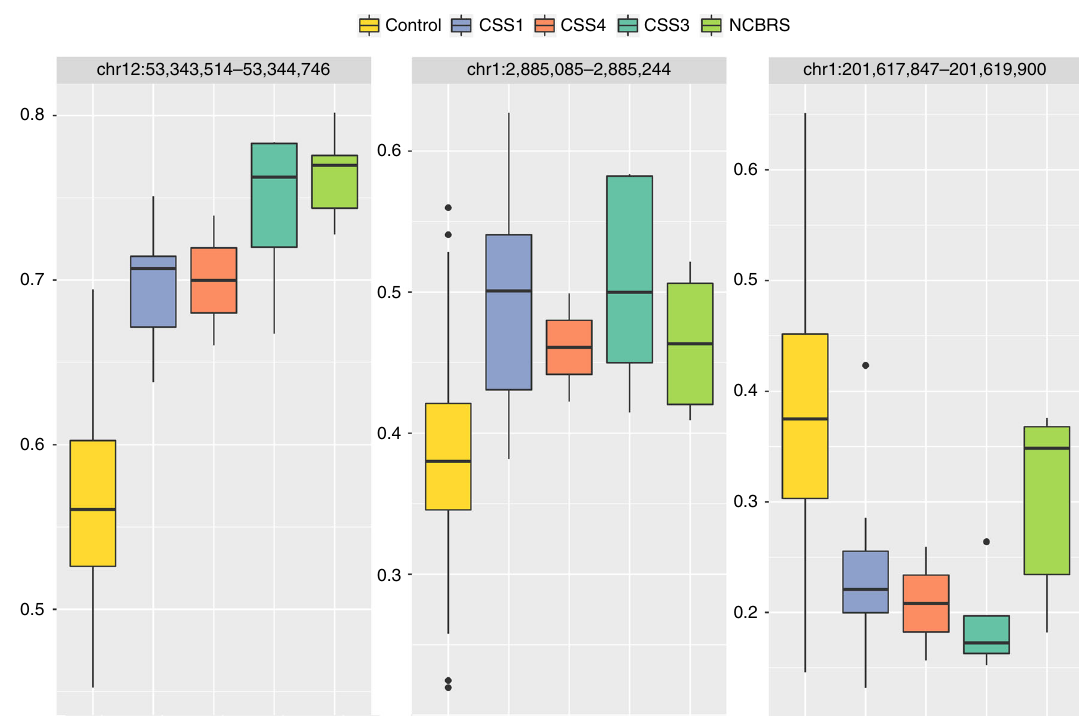
Fig. 5 Genomic regions differentially methylated in CSS1. The fi gure shows the entire three DMRs found to be differentially methylated in CSS1 cases compared to the controls. The box plots represent the distribution of median methylation values across all of the probes mapping to each region as strati fi ed by the subtypes, i.e., Controls, CSS1, CSS4, CSS3, and NCBRS. These regions are detected in the comparison between CSS1 and controls; however, all of them show a similar pattern of methylation in all other CSS/NCBRS subtypes. Center line: median of regional methylation levels across samples; lower and upper bounds: fi rst and third quartiles; whiskers: interquartile